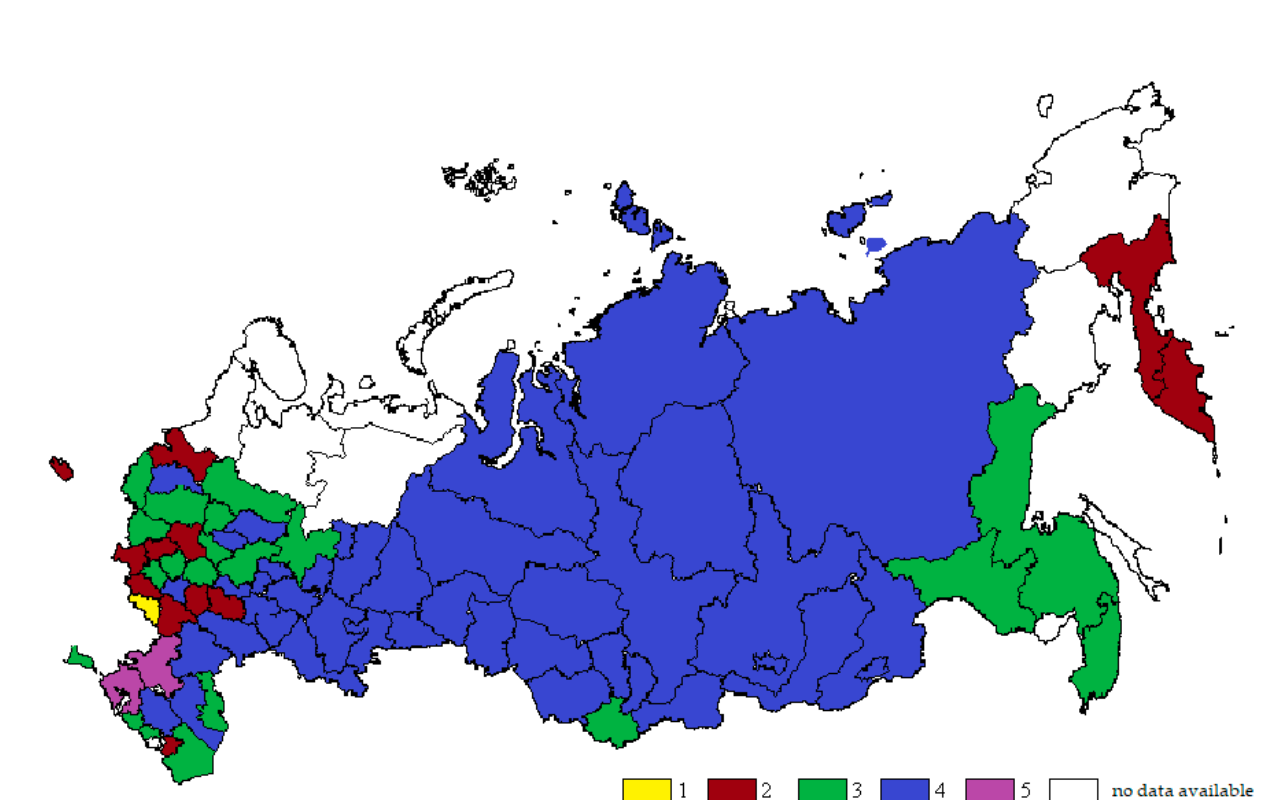
Figure 2. Map of distribution of regions—subjects of the Russian Federation by cluster.